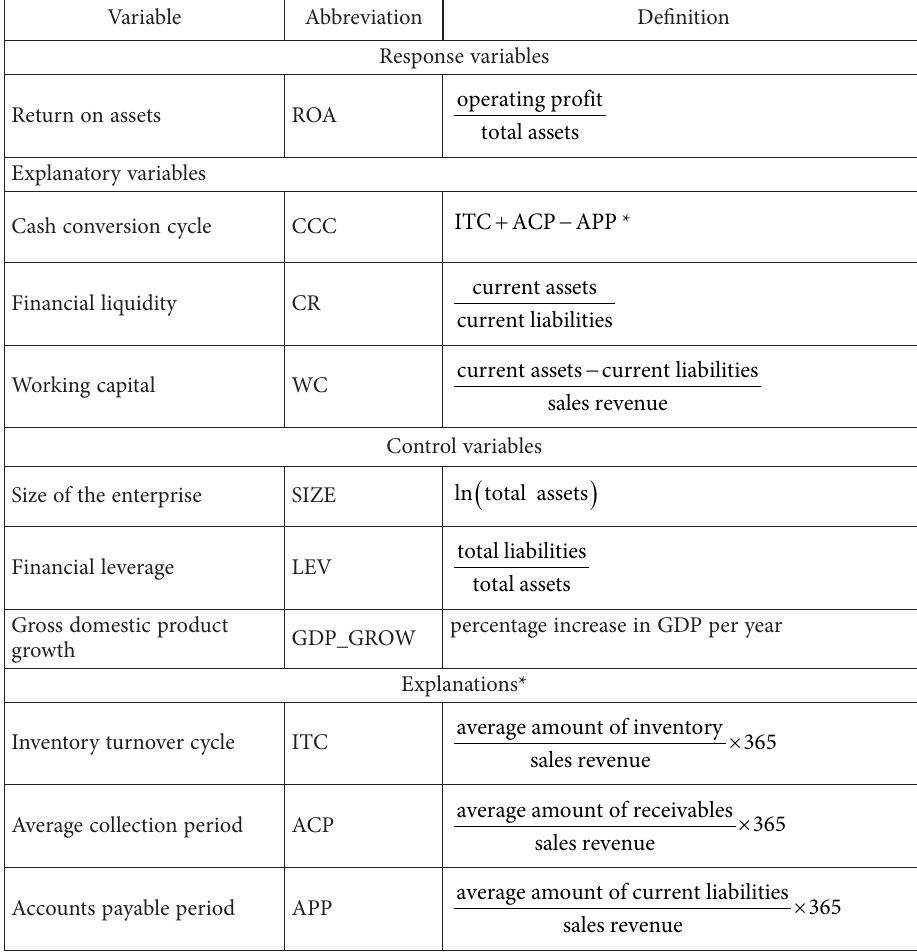
Table 2. Variables used in the study (source: own elaboration)